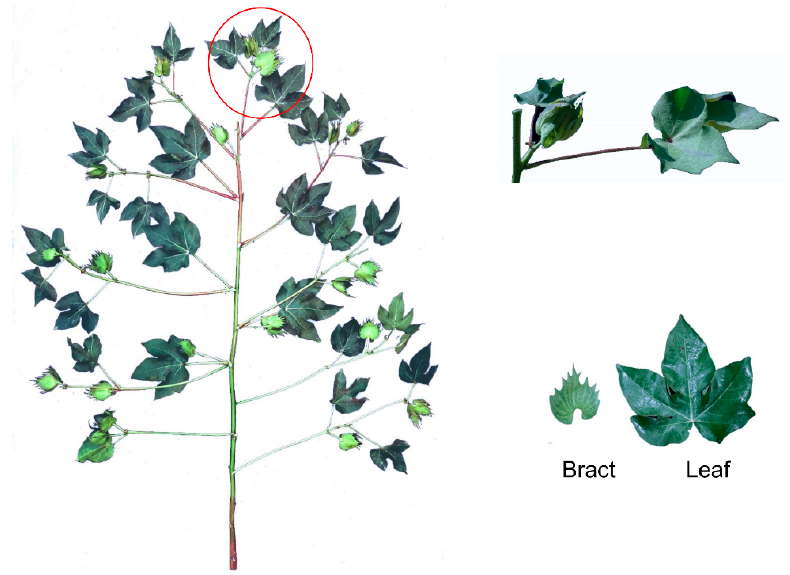
Figure 7. Schematic diagram of cotton leaves and bracts with sampling shown in red circle.